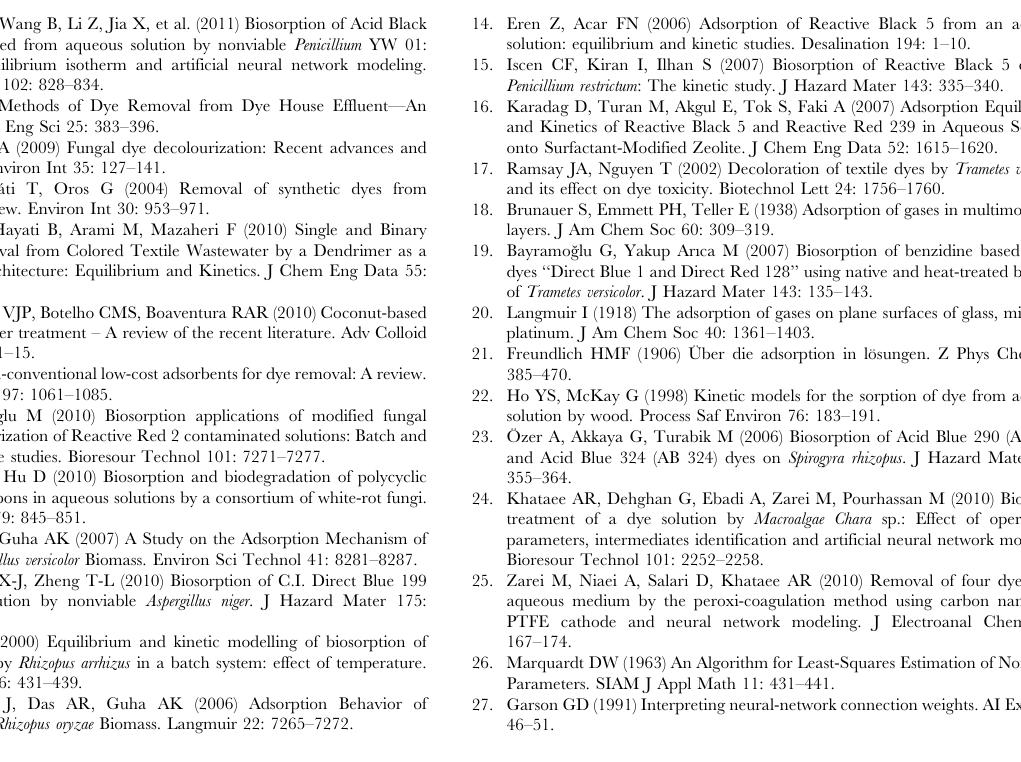
Table S1 The Chemical structure and characteristics of Reactive Black 5. Table S2 The initial biosorption rate of nine biosor- bents for Reactive Black 5. Table S3 Model variables and their ranges for artificial neural network. Table S4 The FTIR Spectral Characteristics of Bio- sorbent F1 Before and After Biosorption of Reactive Black 5. Table S5 The FTIR Spectral Characteristics of Bio- sorbent F4 Before and After Biosorption of Reactive Black 5. Table S6 The FTIR Spectral Characteristics of Bio- sorbent F5 Before and After Biosorption of Reactive Black 5. Table S7 The FTIR Spectral Characteristics of Biosor- bent F7 Before and After Biosorption of Reactive